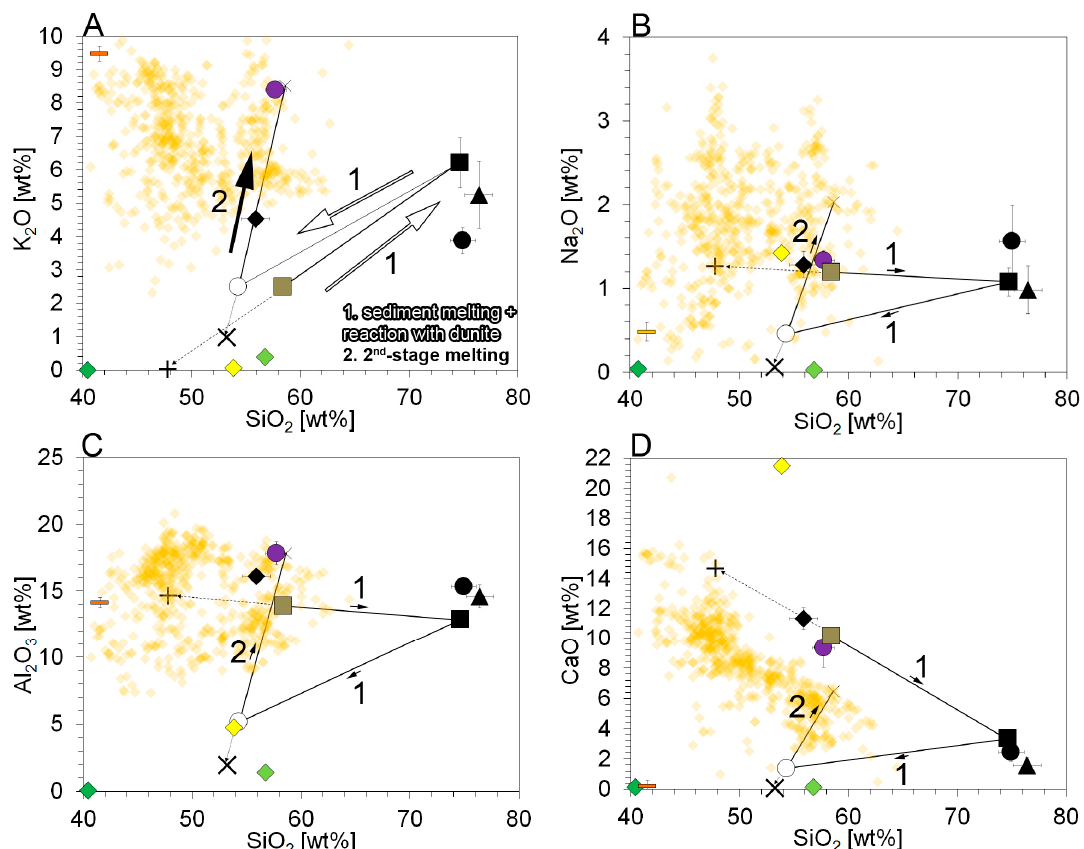
Figure 3. K 2 O ( A ), Na 2 O ( B ), Al 2 O 3 ( C ), and CaO ( D ) versus SiO 2 showing the melt evolution of the 3 GPa/900 °C reaction and 2 GPa/1200 °C second-stage experiment as calculated by mass balance. In the first stage (white arrows), 40% melting of the sediment (brown square) generates an Si-rich melt (black square), leaving a residuum (black plus) comprising 40% garnet and 60% clinopyroxene (Supplementary Figure S1), a Ca-rich and K-poor composition. The Si-rich melt (black square) immediately reacts with olivine (dark green diamond), metasomatizing the adjacent dunite to phlogopite-pyroxenite (open circle). In the second stage, the metasomatized dunite melts to 20% crystallizing a residuum (black cross) comprising 16 wt% olivine, 56 wt% orthopyroxene, and 5 wt% phlogopite. Note that the calculated second-stage melt composition is close to the measured values (purple circle) for K 2 O, Al 2 O 3 , and SiO 2 ( A ) and ( C ). However, Na 2 O and CaO are over- and underestimated, respectively, probably owing to contamination by residual sediment during transfer of the metasomatized dunite to the second-stage experiment. Other symbols: melts of sediment (black circle 800 °C; triangle 850 °C; square 900 °C; diamond 1000 °C), metasome (black star), reaction zone phases (phlogopite, orange rectangle; orthopyroxene, lime diamond; clinopyroxene, yellow diamond).